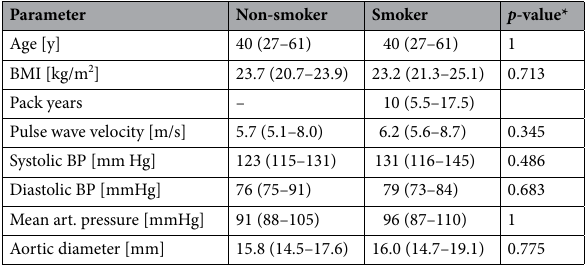
Table 1. Medians and IQRs of demographic data and body measurements as well as blood pressure (BP) and aortic diameter. *Mann–Whitney U test.